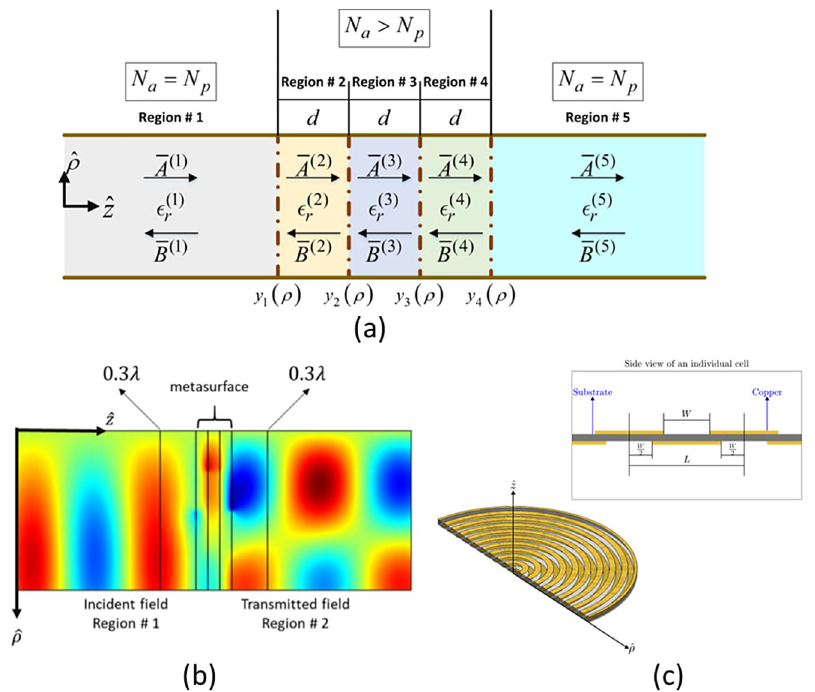
angle refraction. In Ref. [24], the authors also design a wide-angle refracting metasurface for TM polarization and obtain measurements from fabricated samples.